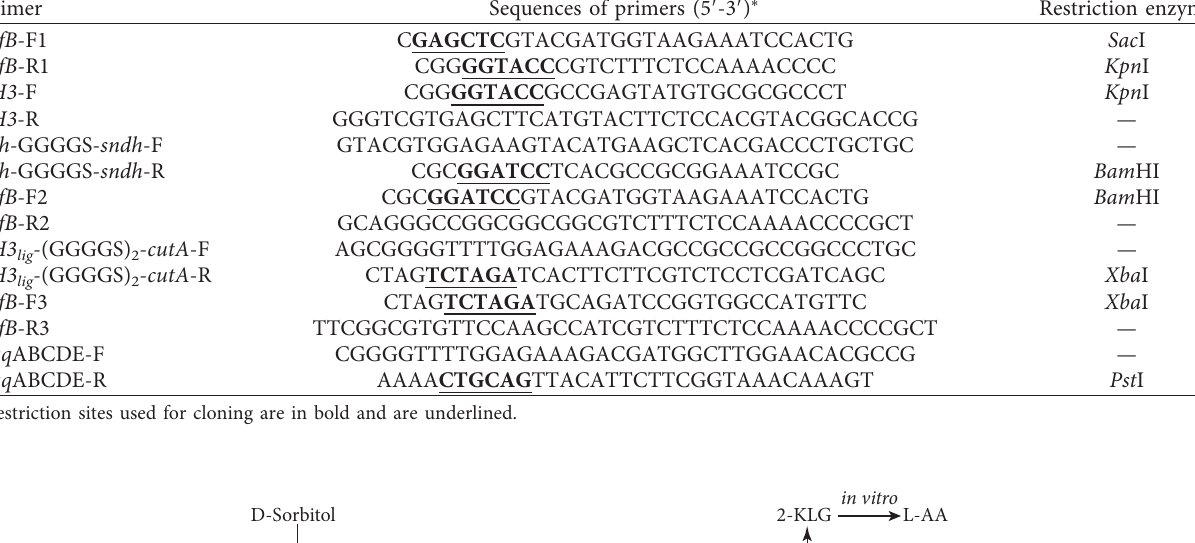
Table 2: Primers used in this study.